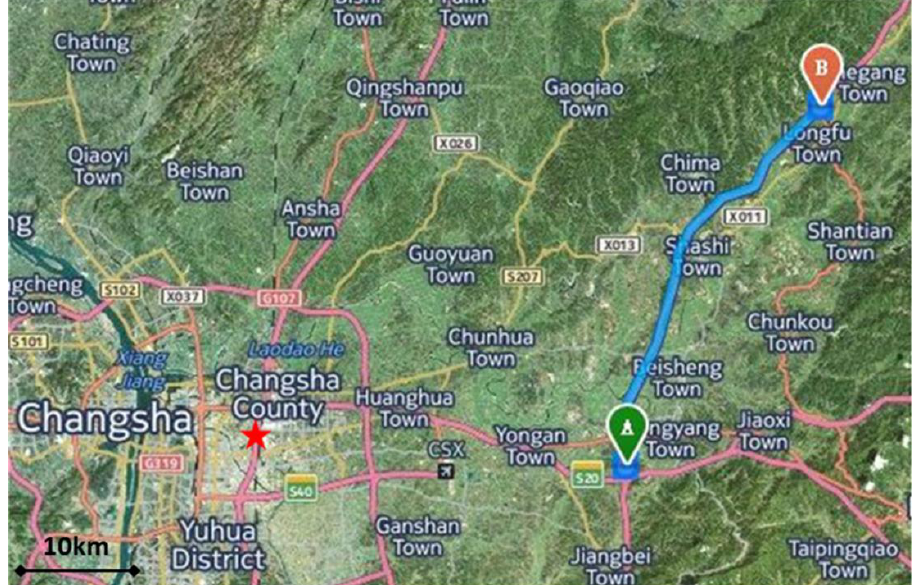
Figure 3. Map of test trajectories in eastern Changsha. The red star was the position of GNSS master station. Blue line from A to B was the test